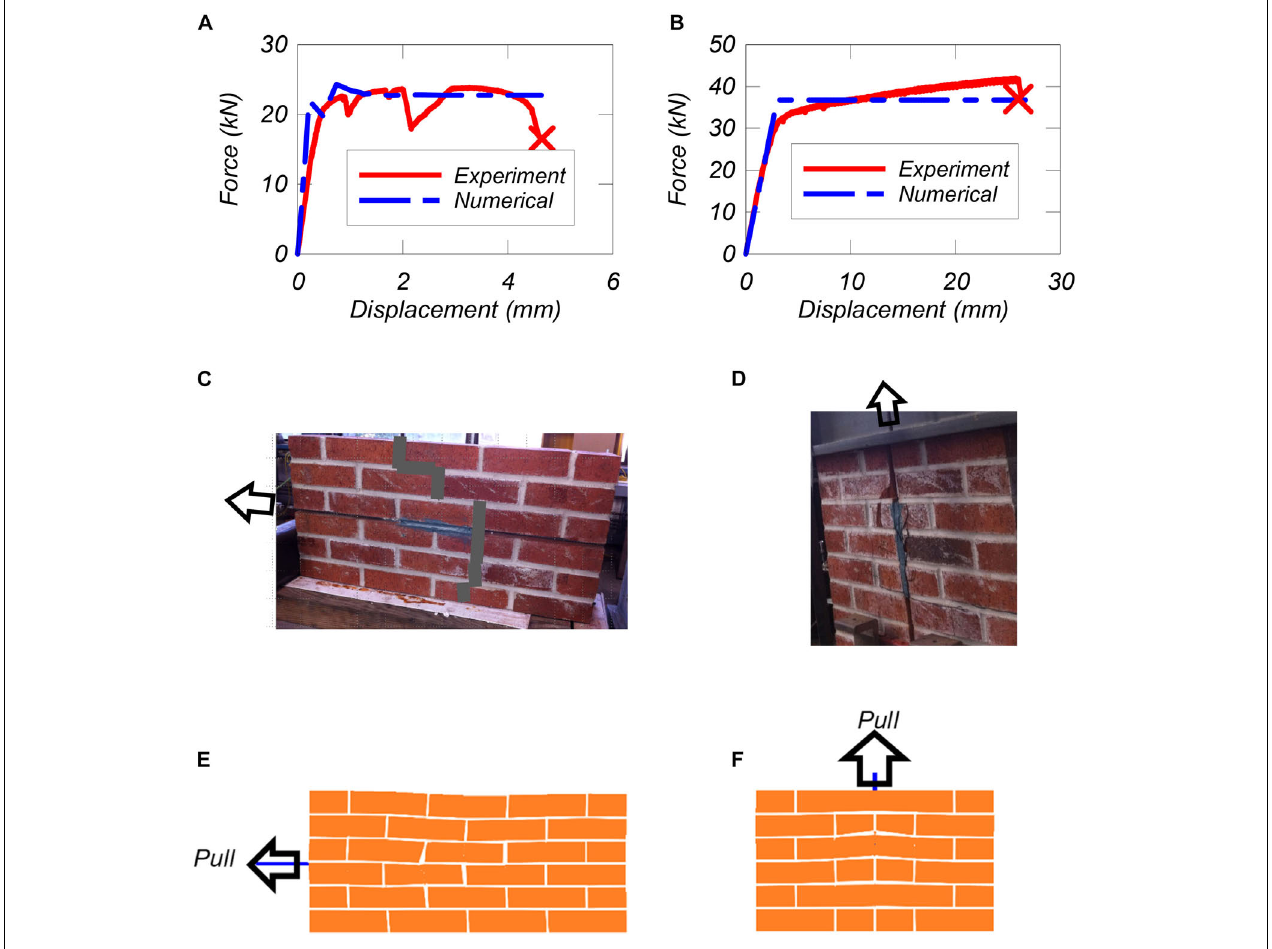
FIGURE 8 | Model validation: (A) load-displacement curves for horizontal bar pull-out, (B) load-displacement curves for vertical bar pull-out, (C) observed cracking patterns of horizontal bar pull-out, (D) observed cracking patterns of vertical bar pull-out, (E) numerical deformed shape for horizontal bar pull-out, and (F) numerical deformed shape for vertical bar